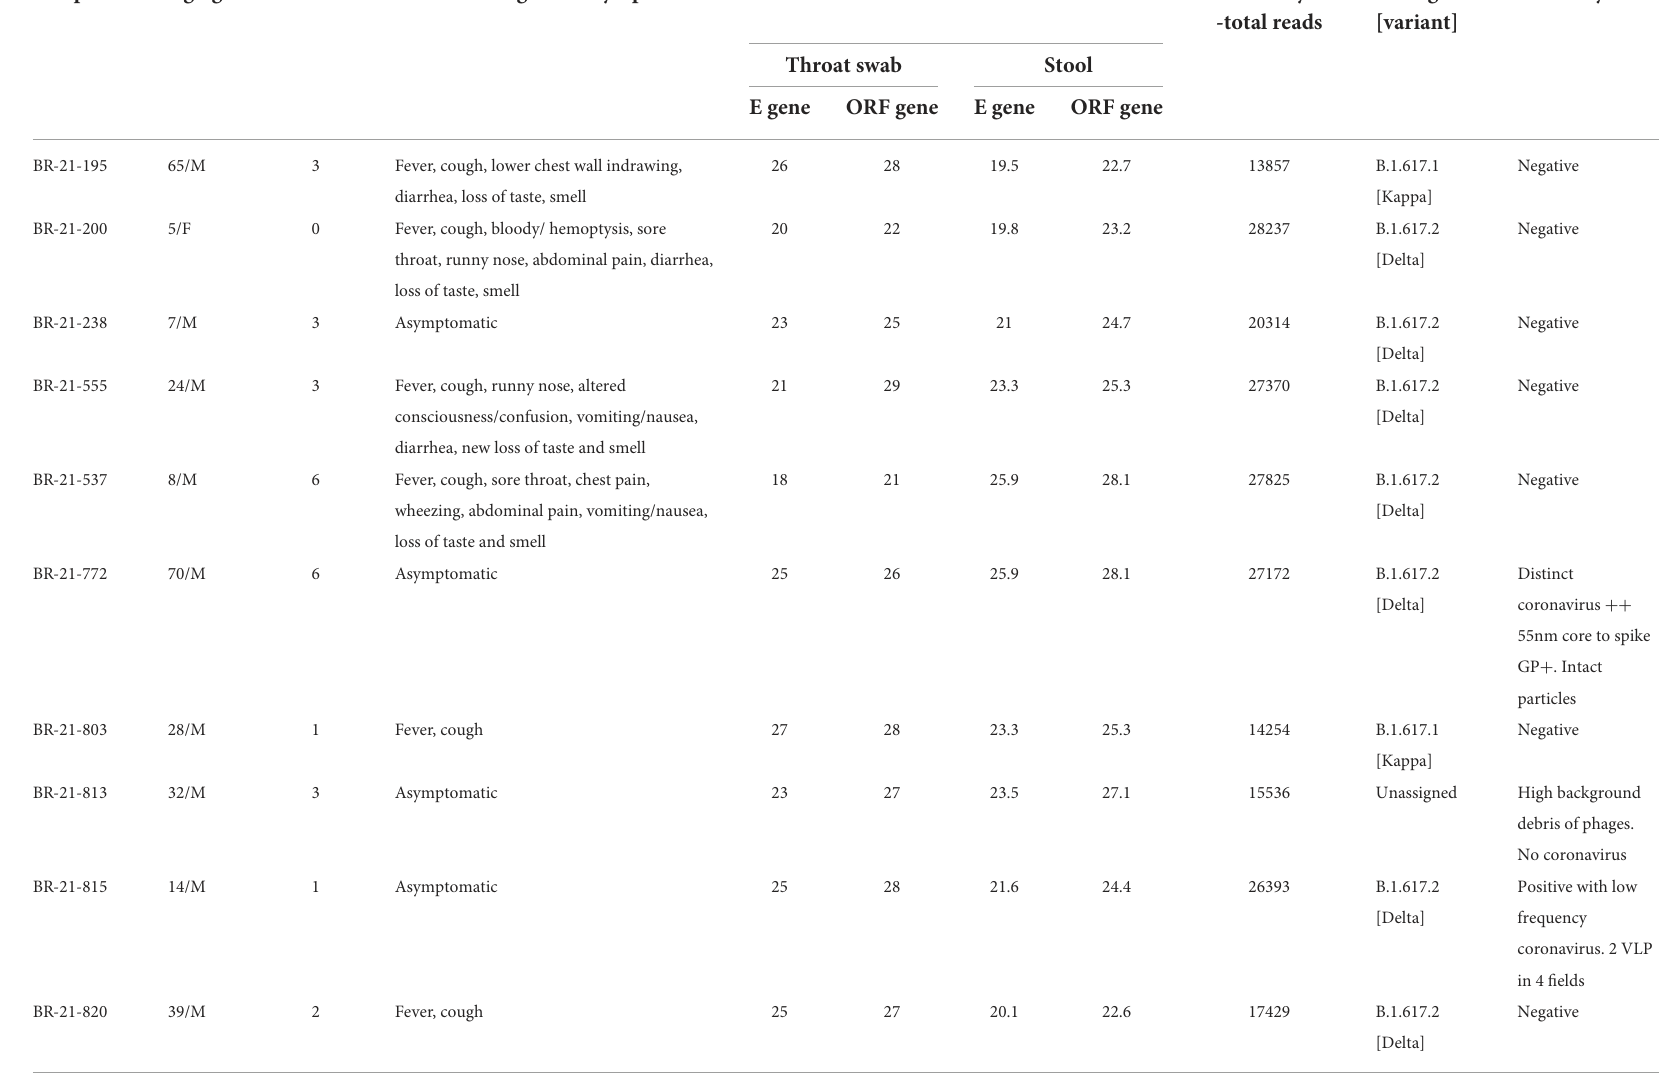
TABLE 1 Clinical and demographic data of the SARS-CoV-2 positive patients along with real-time RT-PCR, next generation sequencing and electron microscopic analysis of the corresponding fecal specimens. Sample